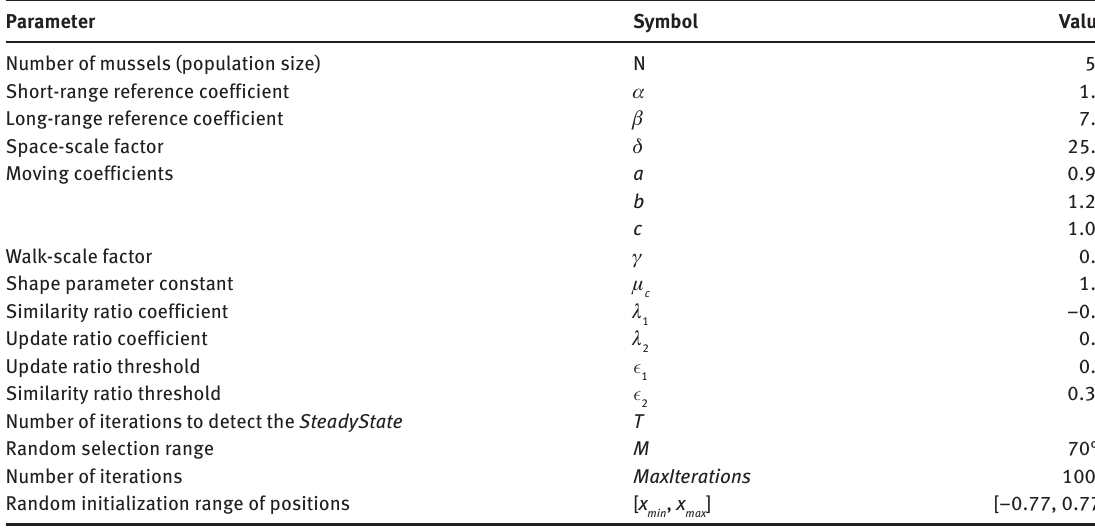
Table 2: Parameter Setting of the E-MWO